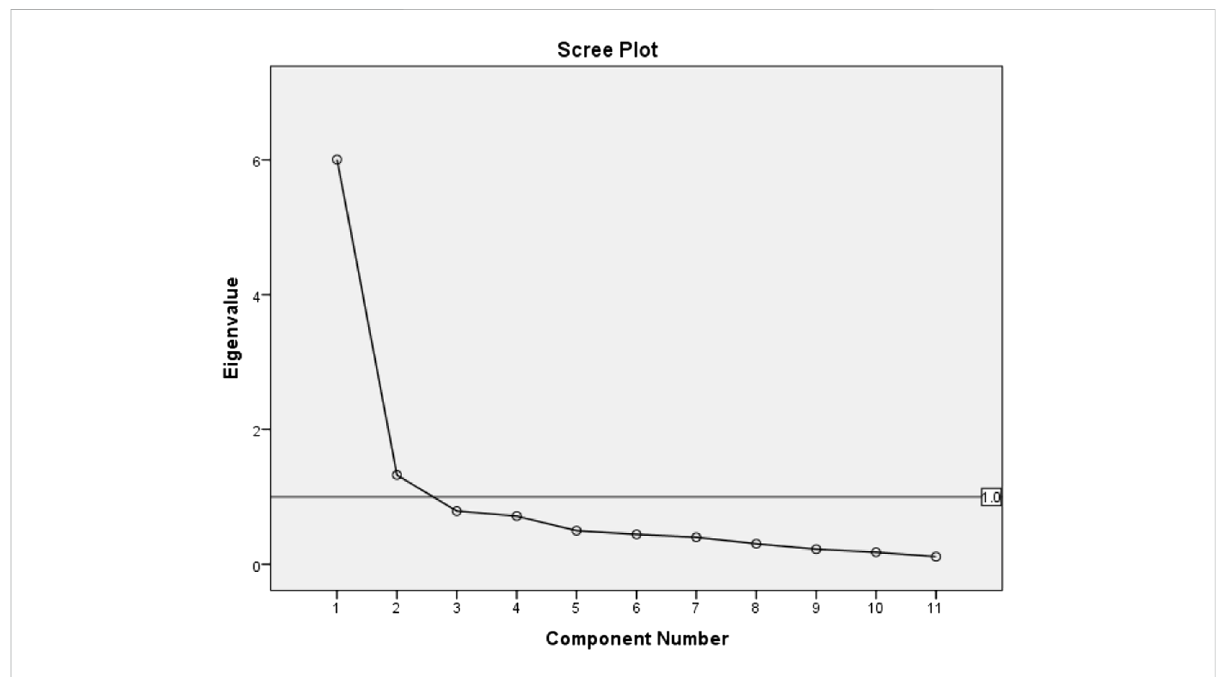
FIGURE 4 Scree plot of identifying the key roles of the